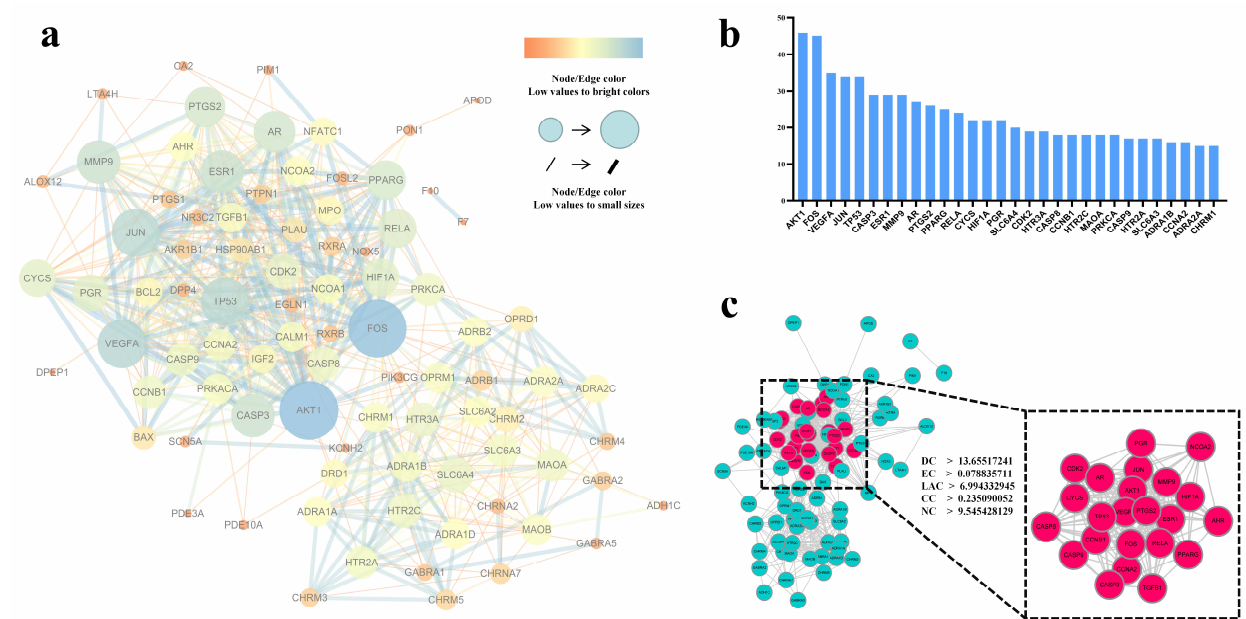
Figure 2. PPI network and key targets. ( a ) PPI network, the higher value the degree of the node in the network, the larger the node and the darker the color, otherwise, vice versa. The higher value of the combined score of the connection between the nodes, the thicker the connection and the darker the color. ( b ) Node degree rank bar chart, X -axis represents the target, Y -axis represents degrees, the chart shows the top 30. ( c ) Discover the key nodes, the nodes whose degree, eigenvector centrality, LAC centrality, closeness centrality, network centrality is greater than 13.65517241, respectively, 0.078835711, 6.994332945, 0.235090052, 9.545428129, are selected as the core nodes. The key nodes are marked in